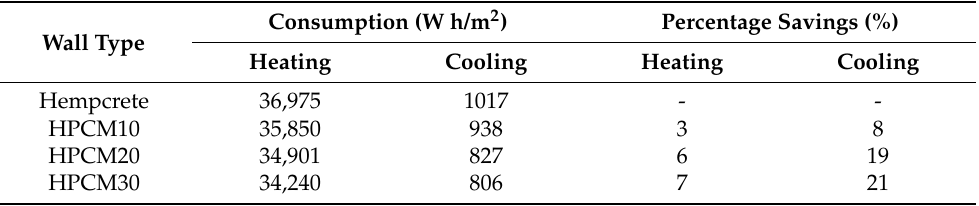
Table 2. Annual energy consumption and percentage savings under BC schedule.